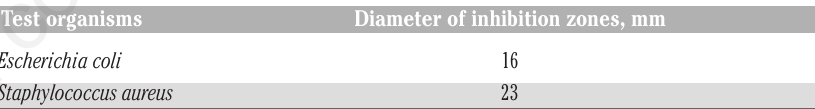
Table 1. Antimicrobial activity of bacteriocin against Escherichia coli and Staphylococcus aureus .